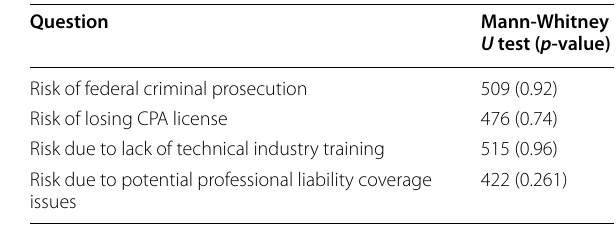
Table 5 Industry risks identified by CPAs who serve vs CPAs who do not serve the industry